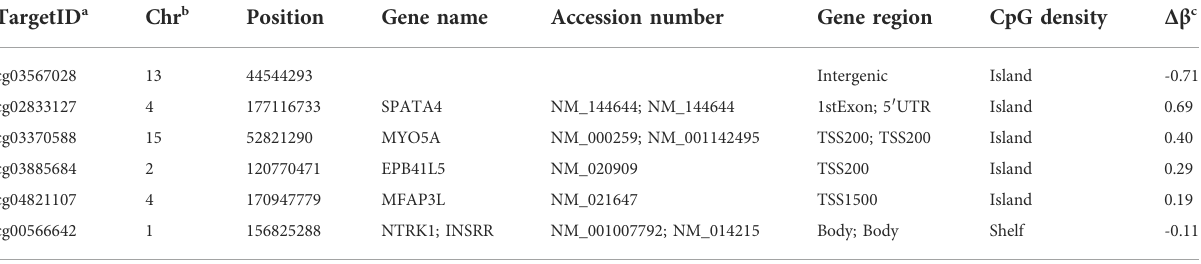
a Identi fi cation of CpG in EPIC array. b